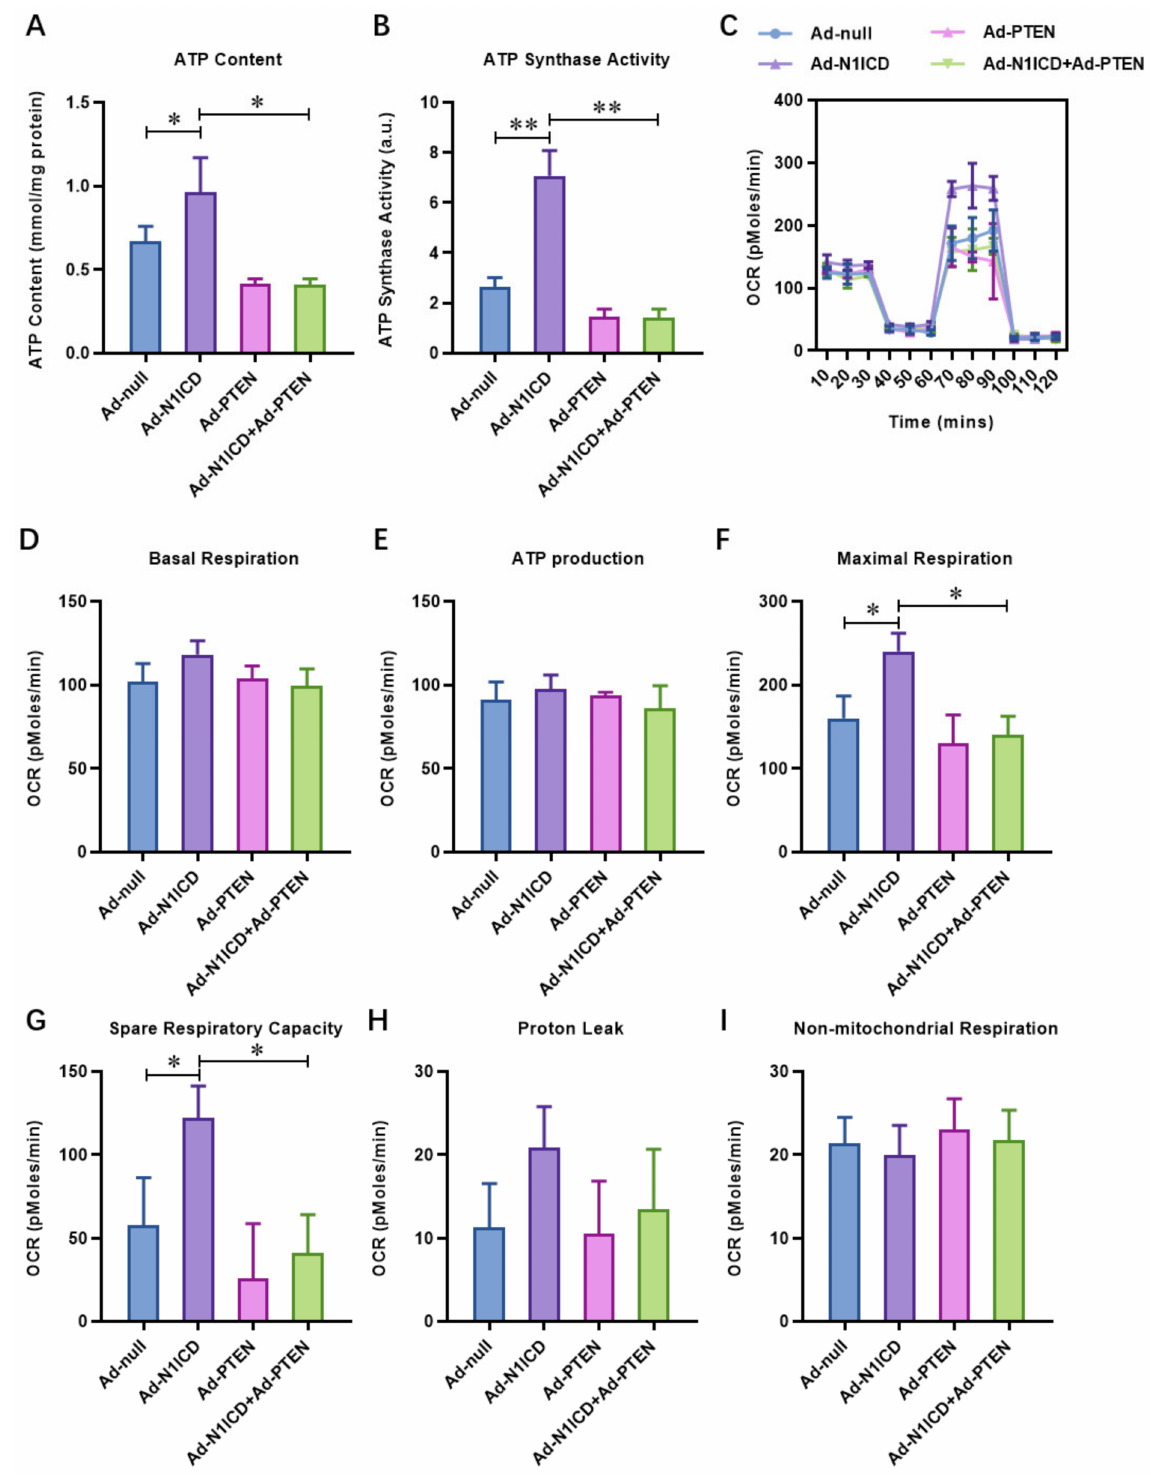
Figure 3. PTEN over-expression impaired the protective effect of N1ICD against hy- poxia/reoxygenation induced mitochondrial dysfunction in neonatal cardiomyocytes. ( A ) The ATP content and ( B ) ATP synthase activity was analyzed by quantitative kits; ( C ) the mitochondrial bioenergetics were measured by the seahorse XFp Extracellular Flux Analyzer. The ( D ) basal respira- tion (BR), ( E ) ATP production, ( F ) maximal respiration (MR), and ( G ) spare respiratory capacity (SPR), ( H ) proton leak, and ( I ) non-mitochondrial respiration were analyzed; N = 3; * p < 0.05, ** p < 0.01 versus indicated